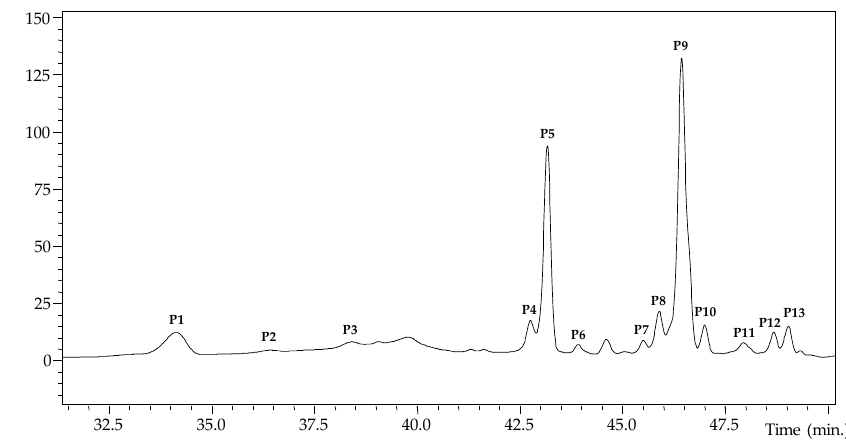
Figure 1. HPLC profile of anthocyanin molecules found in red rubin basil leaves extract obtained in the data set number 18 (as described in Table 2).